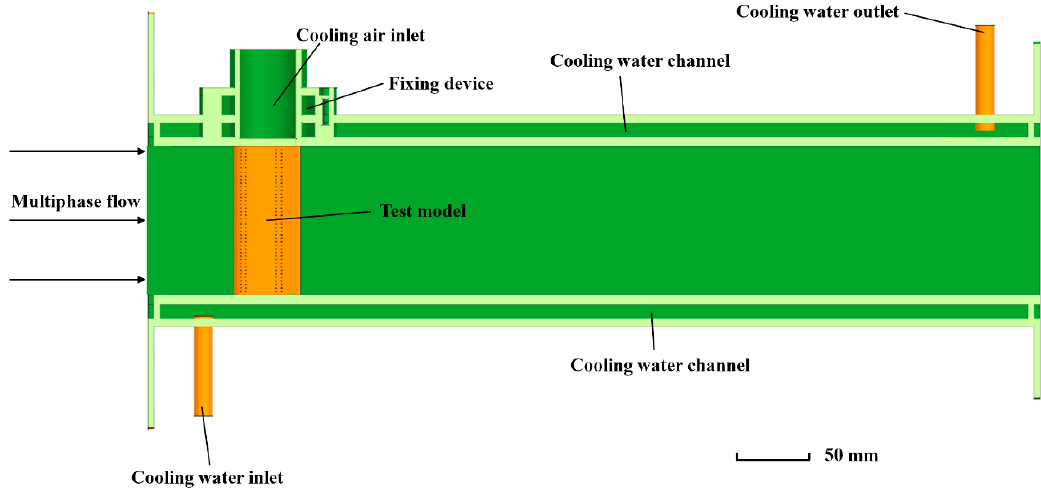
Figure 3. Schematics of the test section.